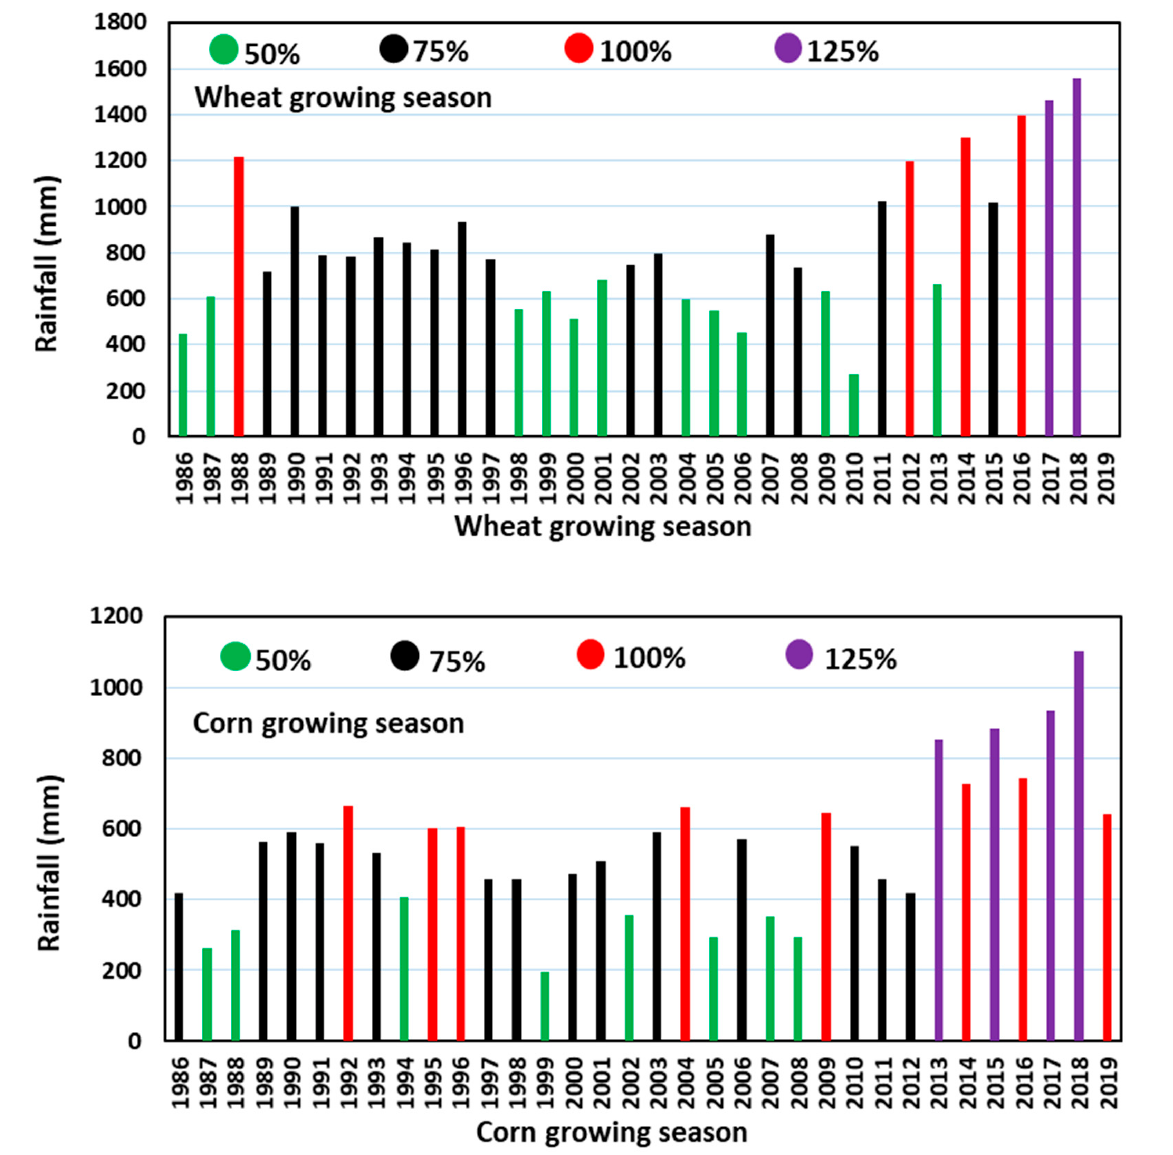
Figure 2. For the wheat growing season, 100% is the 2016–2017 season (red color category). For the corn growing season, 100% is the 2019 season (red color category). When multiplying the wheat/corn growing seasons by 50%, the results are shown by the green color category. For example, the growing seasons of 2001 and 1988 for wheat and corn, respectively. When multiplying the wheat/corn growing seasons by 75%, the results are denoted by the black color category. For example, the growing seasons of 1990 and 2000 for wheat and corn, respectively. When multiplying the wheat/corn growing seasons by 125%, the results are denoted by the purple color category. For example, the growing seasons of 2018 and 2013 for wheat and corn, respectively.